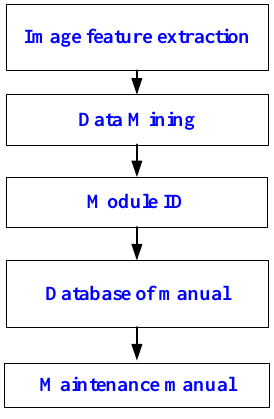
Figure 13. The database searching